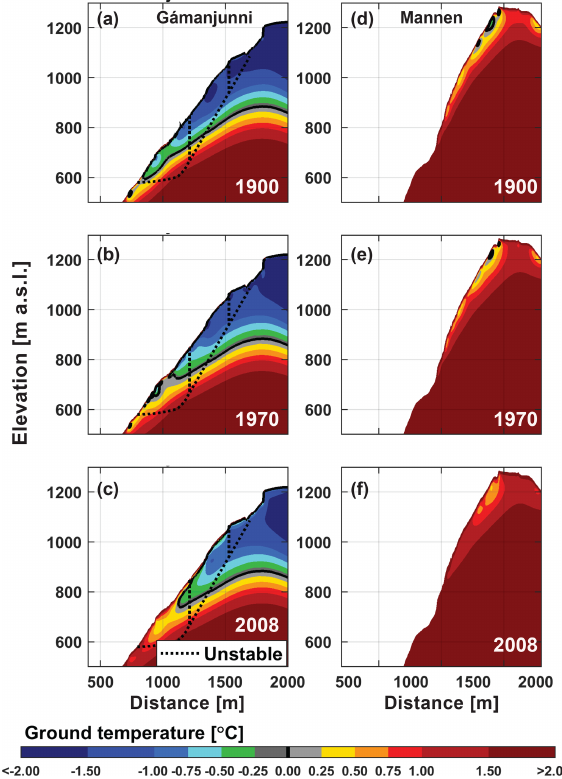
Figure 7. Modelled mean annual ground temperature for Gámanjunni-3 (a–c) and Mannen (d–f) for three different years (1900, 1970 and 2018). The stippled line denotes the instability at Gámanjunni-3 based on Böhme et al. (2016). The black solid lines in the plots show the 0 ◦ C isotherm. For parameterisation and sen- sitivity plots, see Figs. A1 and